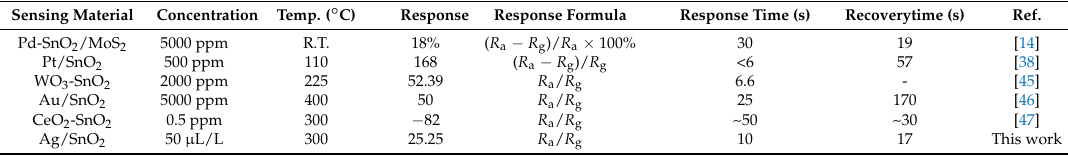
Table 2. Summary of the H 2 gas sensing performances of different gas sensor materials. Sensing Material Concentration Temp. ( ◦